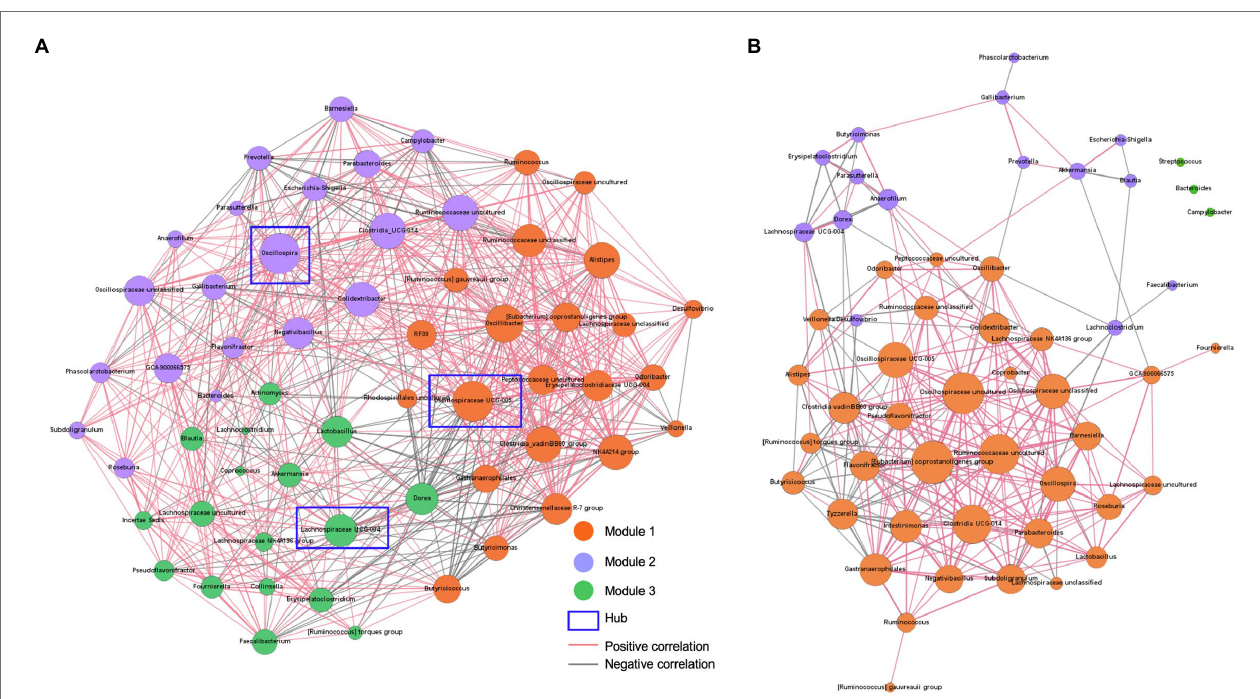
FIGURE 5 | Bacterial-bacterial interactions predicted by co-occurrence networks. (A) Bacterial co-occurrence network in normal feces. (B) Bacterial co- occurrence network in abnormal feces. Co-occurrence networks predicting the bacteria-bacteria interactions among core bacterial genera (present in more than 50% of normal or abnormal fecal samples) in calf feces. Connections were detected based on Spearman’s rank correlations ( rs > 0.2 or rs < − 0.2, FDR adjusted p value < 0.05). Dot sizes represent number of connections with other taxa. Thickness of lines represents strength of relatedness. The modules were designated based on a community detection